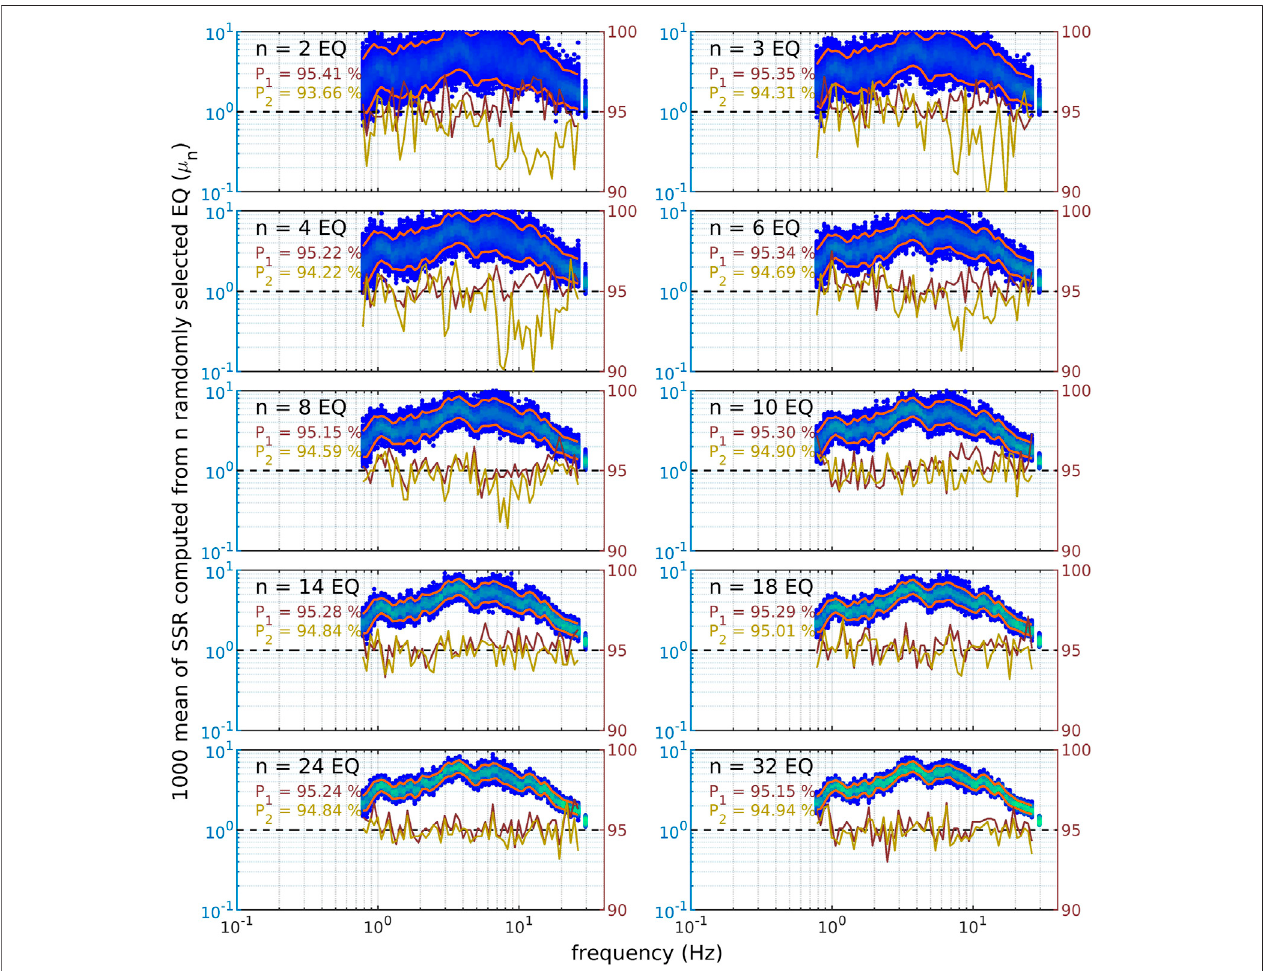
FIGURE 7 | Evaluation of P1 (dark brown line) and P2 (light brown line) on the standard spectral ratio computed at Swiss station SIOO/SIOV from 1000 randomly selected subsets of n (cid:1) [ 234681014182432 ] earthquakes (top-left tobottom-right panel). On each panel, theleft axis provides the ampli fi cation scale and the right axis indicates P1and P2proportion inpercentages. The1000local means x n arerepresentedaccordingtotheir density ofpoints from darkblue tolightgreen. The total 95% con fi dence interval prediction for n events ( Ic 95 N ) is represented with orange lines. P1 can be easily visualized by looking at the proportion of x n points exceeding the Ic 95 N (blue points outside the orange lines). There is no way to simply represent P2 here. The number of events, and the mean P1 and P2 over the frequency range are written on each panel.